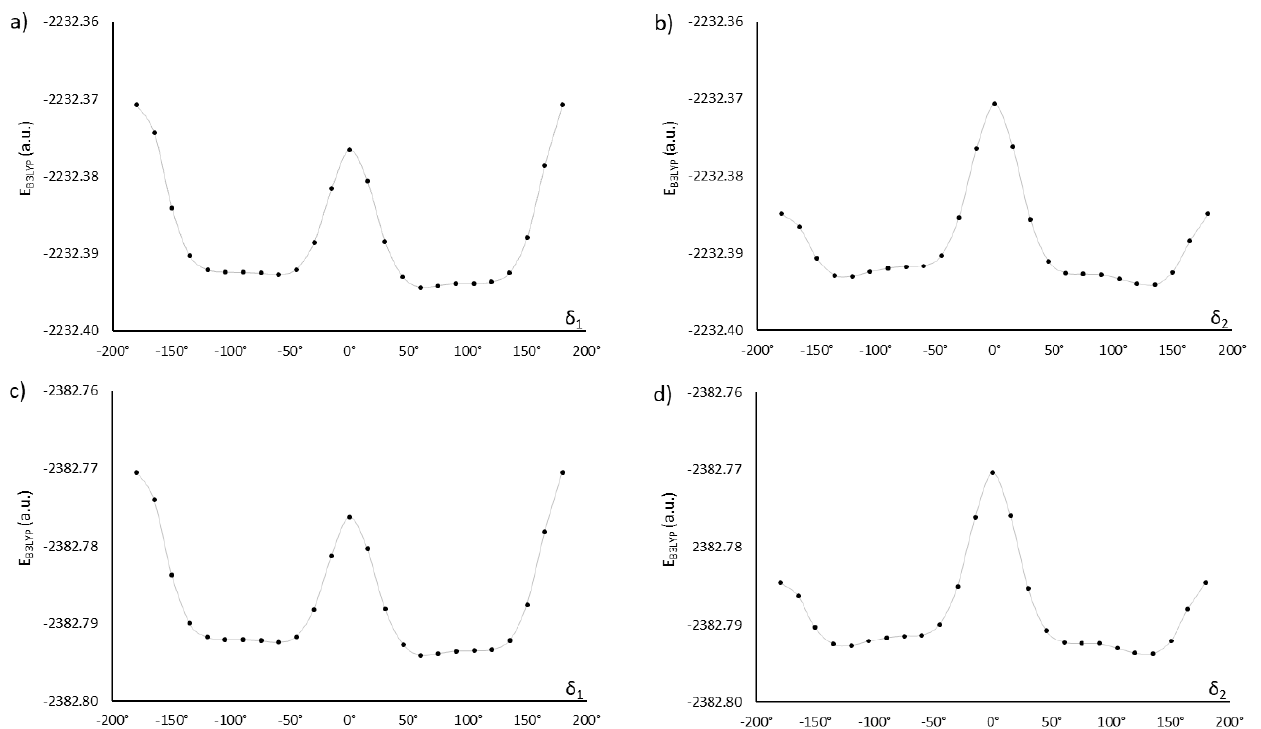
Figure 2. Energy changes in relation to the mutual orientation of phenyl rings and ester groups (described by dihedral angles δ 1 and δ 2 ) in monomers M22 ( a , b ) and MU22 ( c , d ). The solid lines are guides to the eye.